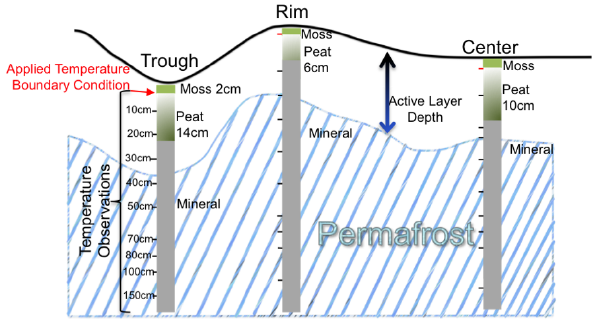
Figure 3. Diagram of the three 1-D columns and the associated measured soil temperature